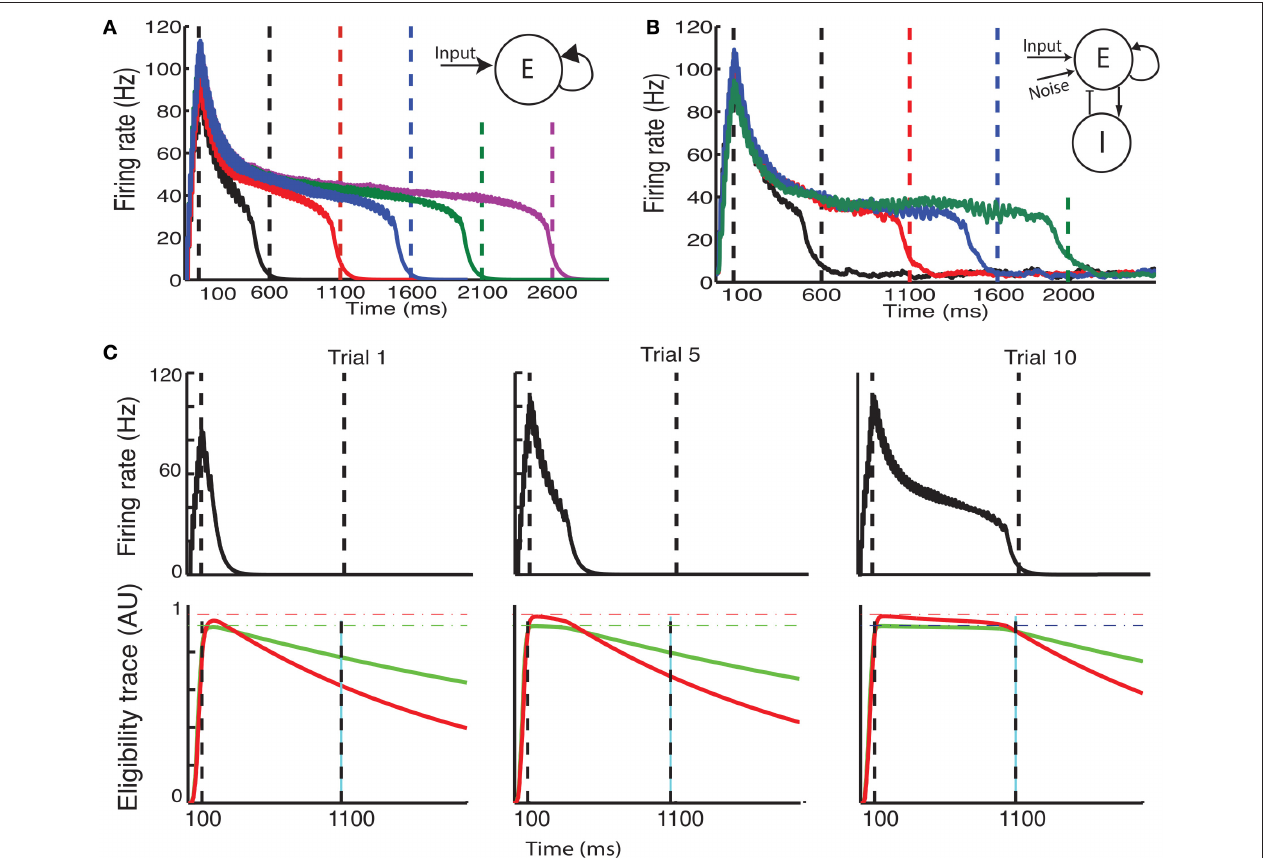
FIGURE 2 | The CRL in a recurrent neural network. (A) With a two-trace rule, an integrate-and-fire network with excitatory recurrent connections can learn to generate different interval times. (B) In a two-population network with fixed inhibitory connections, plastic excitatory connections, and external noise, a large range of interval times can be learned as well. (C) Illustration of the learning process in a recurrent network. Initially (Trial 1, left) the network activity (top panel) quickly decays and so do the LTP (green) and LTD (red) associated eligibility traces (bottom panel). At the time of reward (vertical dashed line) the LTP trace dominates and recurrent connections are strengthened resulting in longer lasting network activity. After 5 trials (middle panel) the network activity lasts for longer, and traces reach saturation (dashed lines). At the time of reward LTP traces still dominate, resulting in an extension of the network time constant. After 10 trials (right), network activity extends almost to the time of reward, and the traces are equal at the time of reward. Therefore, there is no change in the strength of lateral connection and the synaptic plasticity reaches a steady